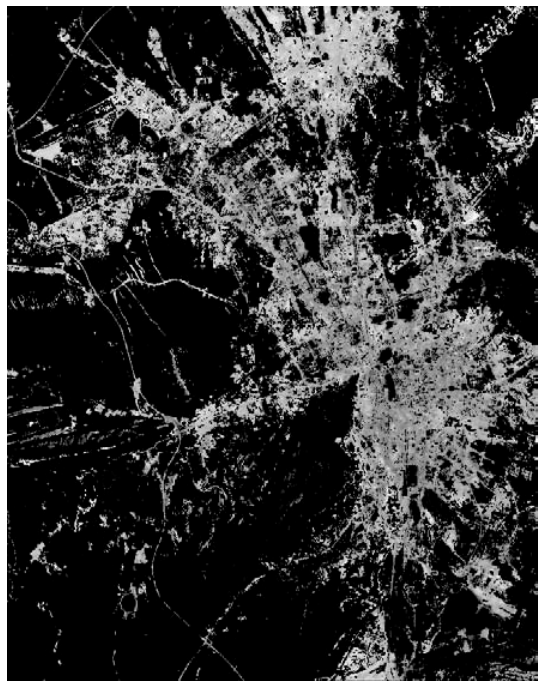
Figure 4 Mask image of urban area.